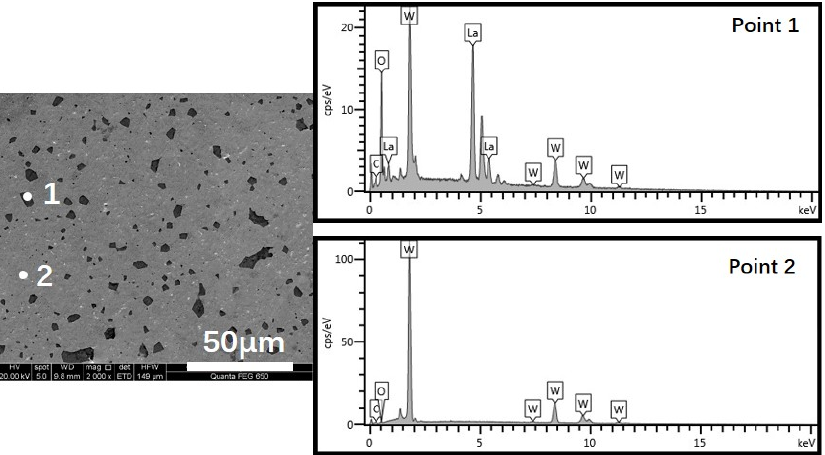
Figure 4. SEM and EDS images of the sample without doping ZrH 2.